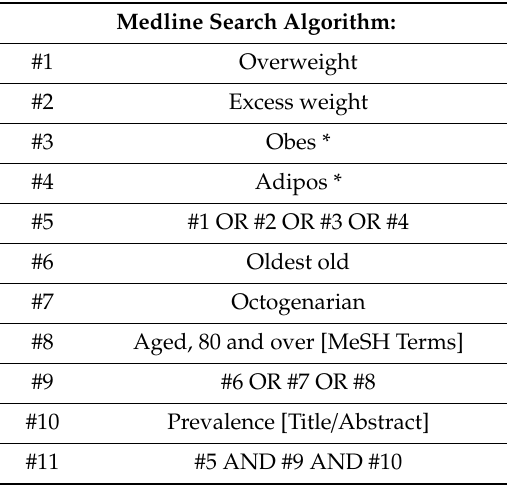
Table 1. Search strategy